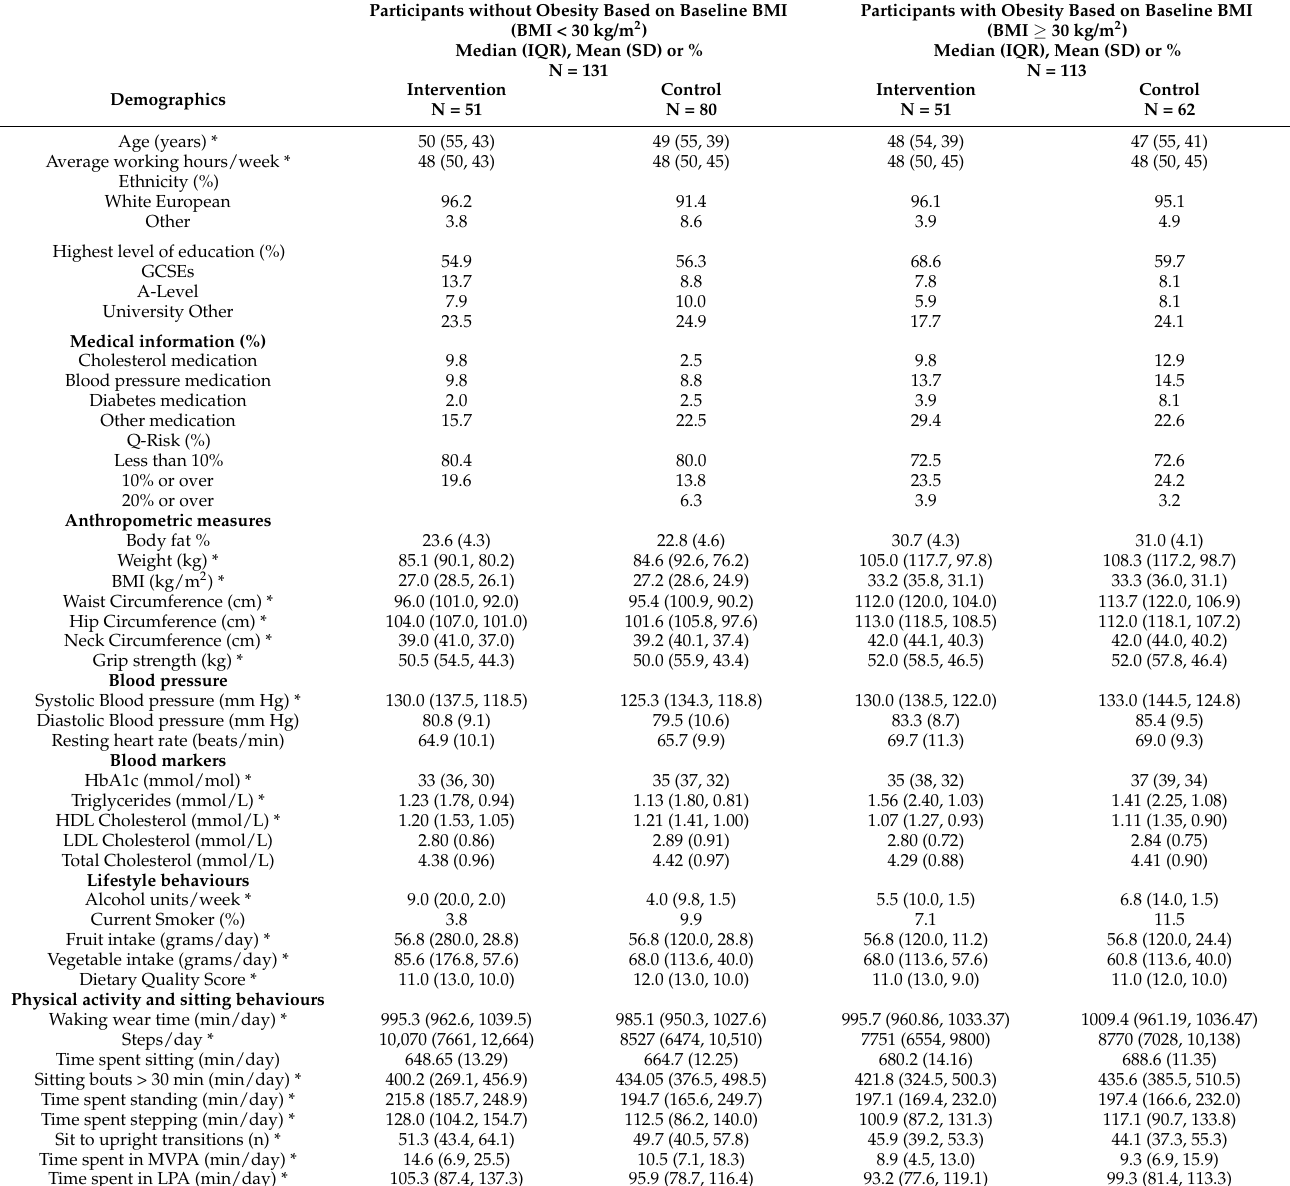
Table 1. Baseline characteristics for participants with versus without obesity based on BMI. Participants without Obesity Based on Baseline BMI (BMI < 30 kg/m 2 ) Median (IQR), Mean (SD) or % N = 131